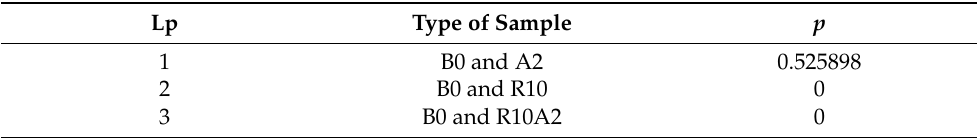
Table 4. p -values of Student’s t -tests for paired samples.